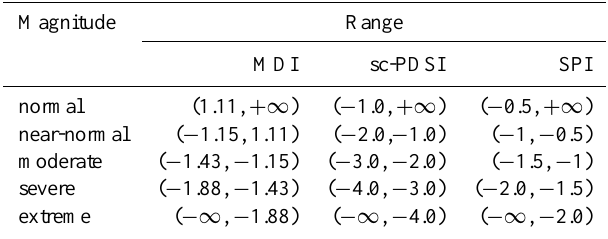
Table 2. The dryness thresholds of the MDI, the sc-PDSI and the SPI.